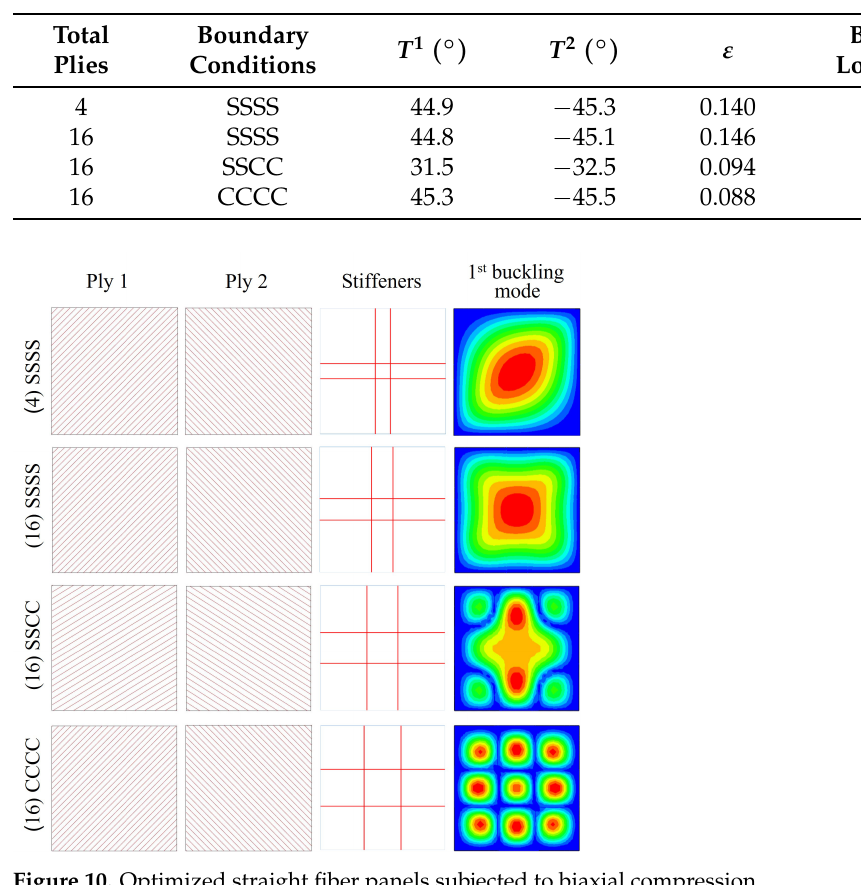
Table 3. Optimization results of straight fiber panels subjected to a biaxial compression load.